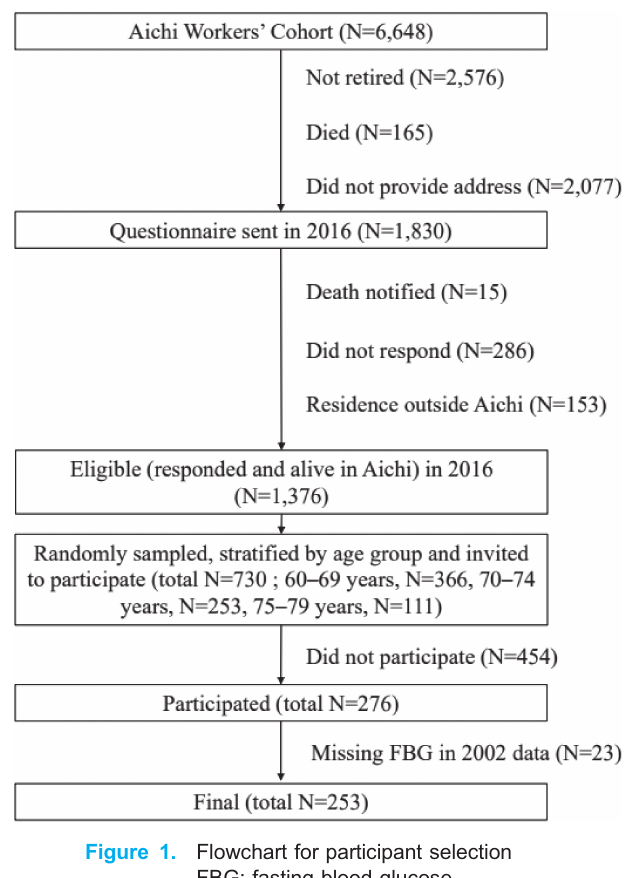
Figure 1. Flowchart for participant selection FBG: fasting blood